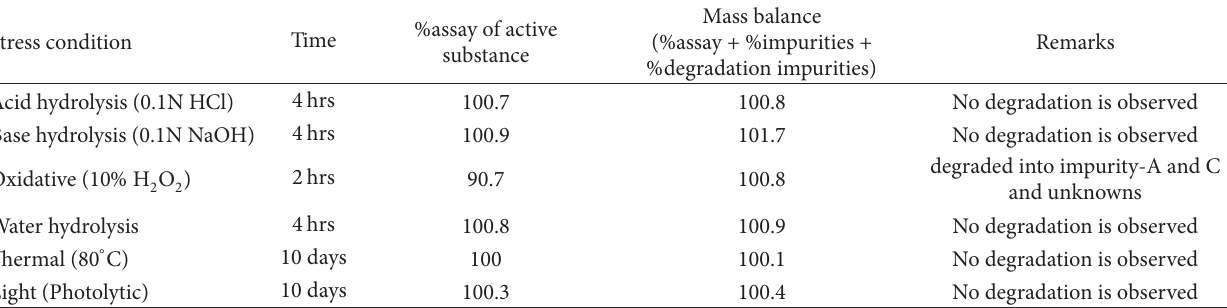
T 7: Summary of forced degradation